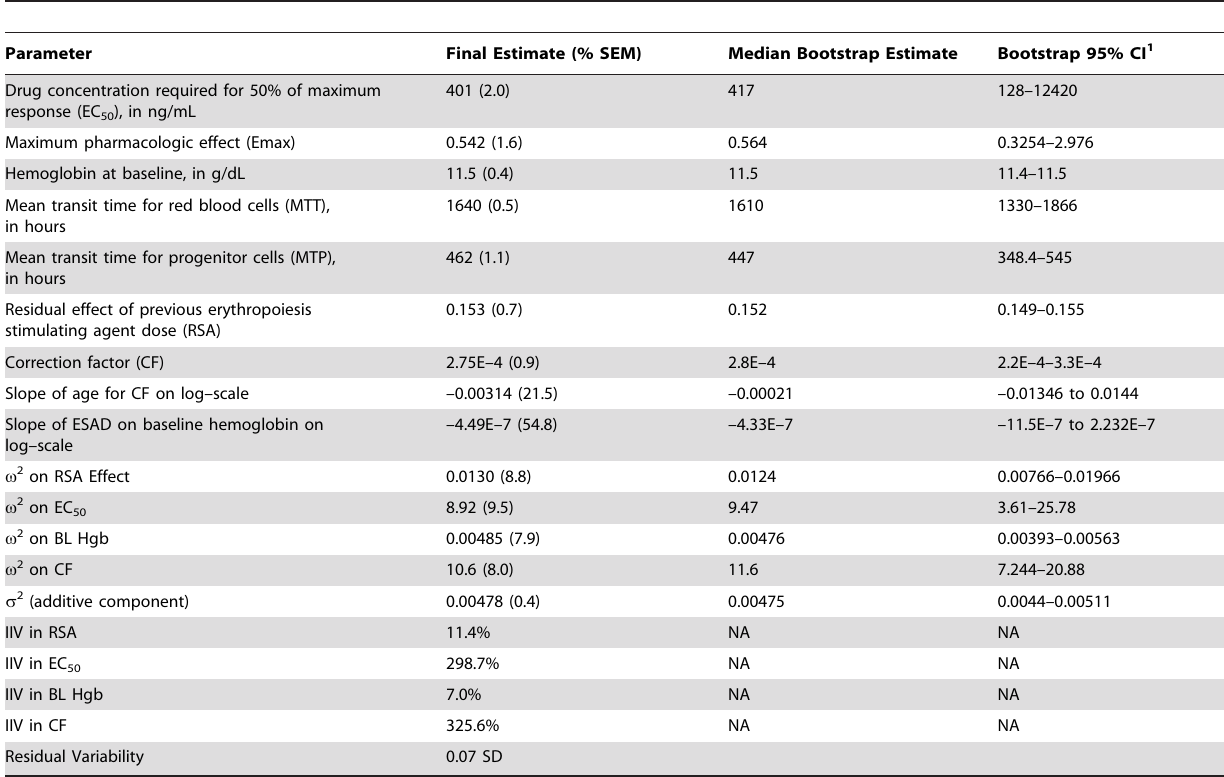
Table 7. Peginesatide parameter estimates and their associated precision for the final PK-PD Model, including bootstrap evaluation